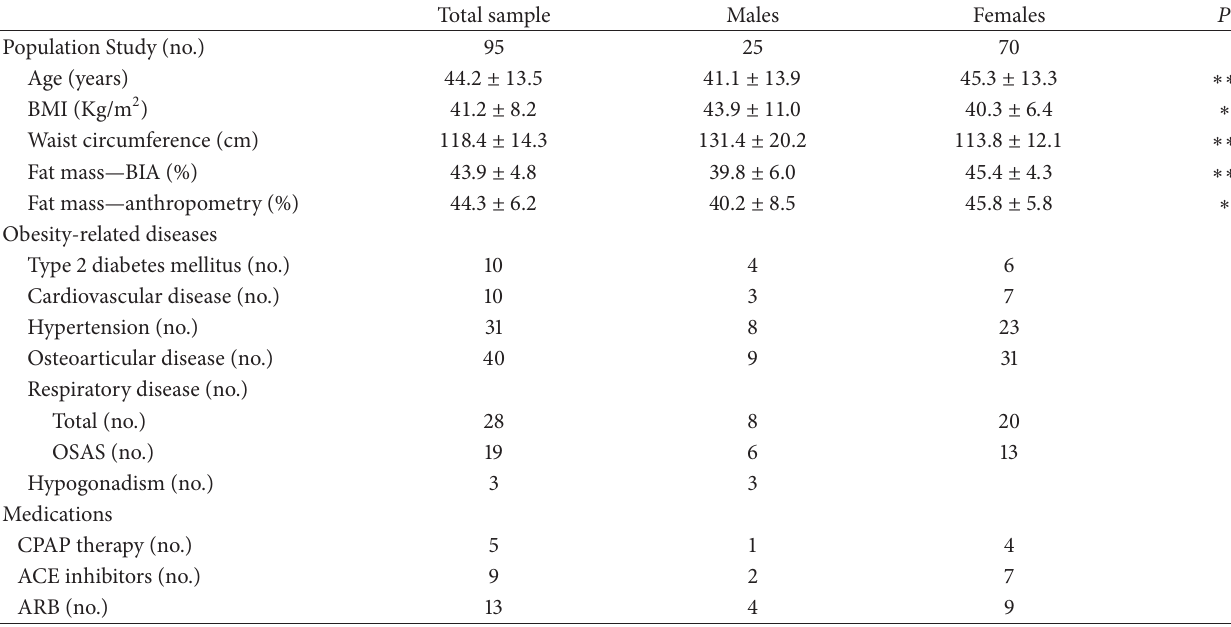
Table 1: Demographic and clinical